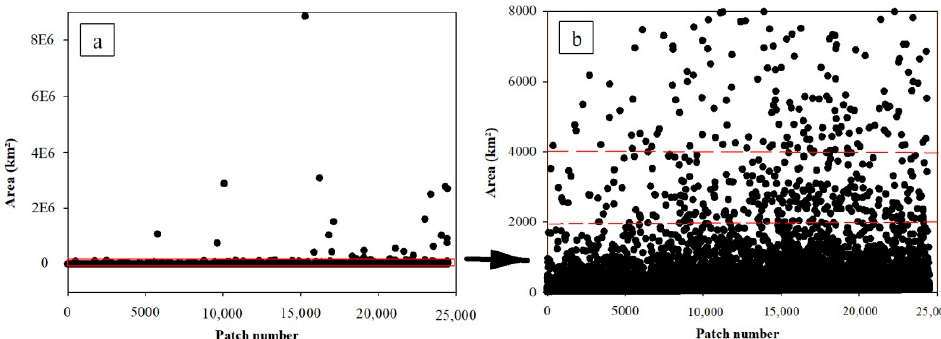
Figure 7. Area statistics of nine-classification patches: ( a ) size distribution of patches; ( b ) drawing of partial enlargement.